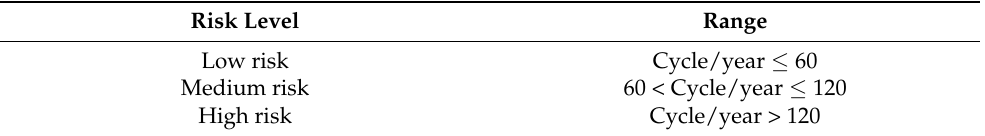
Table 5. Risk levels associated with the number of transition cycles per year for the Halite, and the Th é nardite and